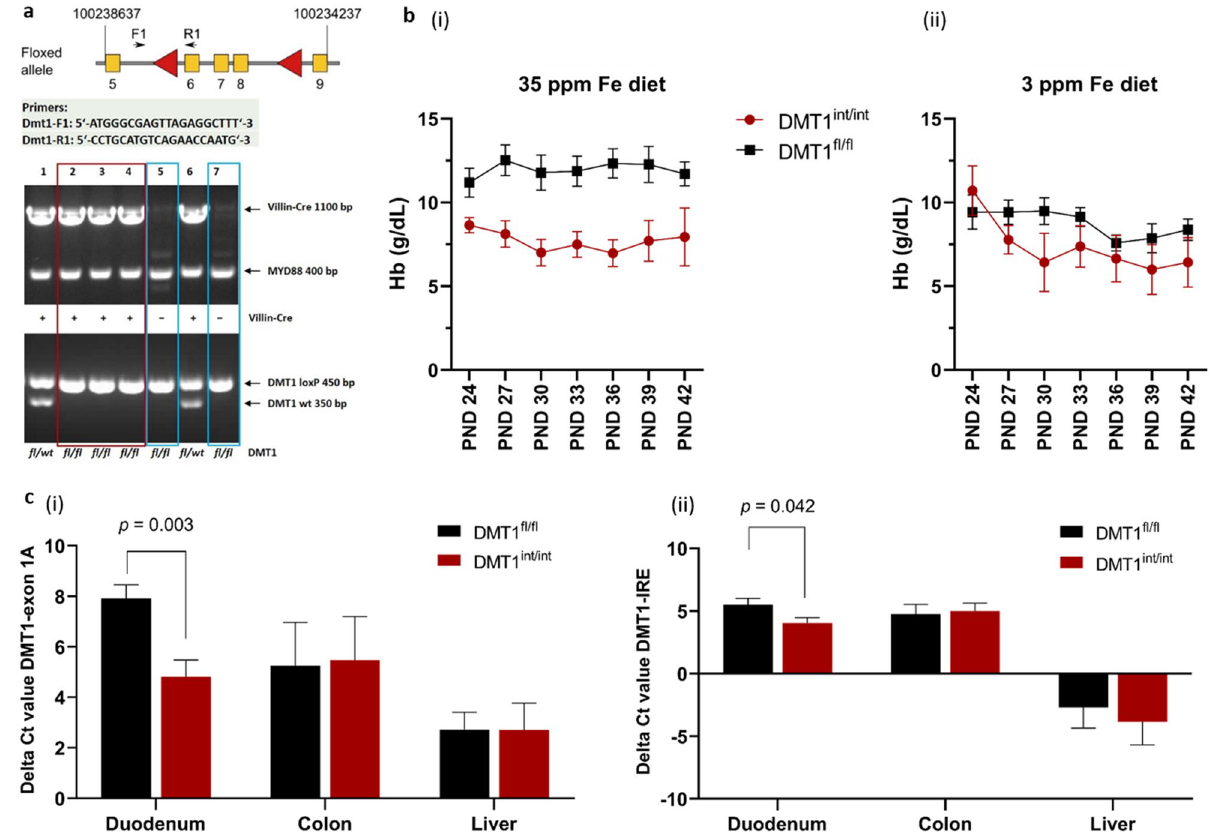
Figure 2. Characterization of the DMT1 int/int mouse model. (a) Schematic illustration of the floxed allele and primer positions used to confirm excision by PCR genotyping of intestine knockdown (DMT1 int/int , lane 2–4, red box) and control (DMT1 fl/fl , lane 5 and 7, blue boxes) mice. Image was cropped and compiled from original images available as Supplementary Figs. 1 and 2. ( b) Haemoglobin (Hb) trajectory (PND 24 ‒ 42) in DMT1 int/int (n = 6 male; n = 4 female) and DMT1 fl/fl (n = 10 male; n = 11 female) mice receiving the AIN93G diet containing (i) 35 ppm iron (as ferrous citrate) and (ii) 3 ppm iron (native). Results are shown as means ± SEM. c, Expression of (i) DMT1-exon1A and (ii) DMT1-IRE mRNA in duodenum, colon and liver of 42-day-old DMT1 int/int and DMT1 fl/fl mice fed an iron deficient (3 ppm iron) diet from PND 24 ‒ 42, normalized to 18S and βActin as endogenous reference genes to calculate delta Ct values. Differences in gene expression by genotype (DMT1 int/ int vs. DMT1 fl/fl ) were determined by two-sided independent t-tests. The results are shown as means ± SEM and differences were considered significant at p <